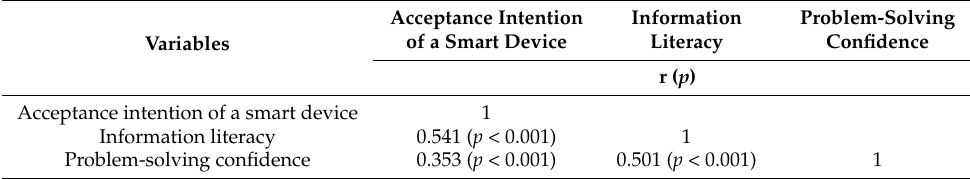
Table 2. Correlation among variables.